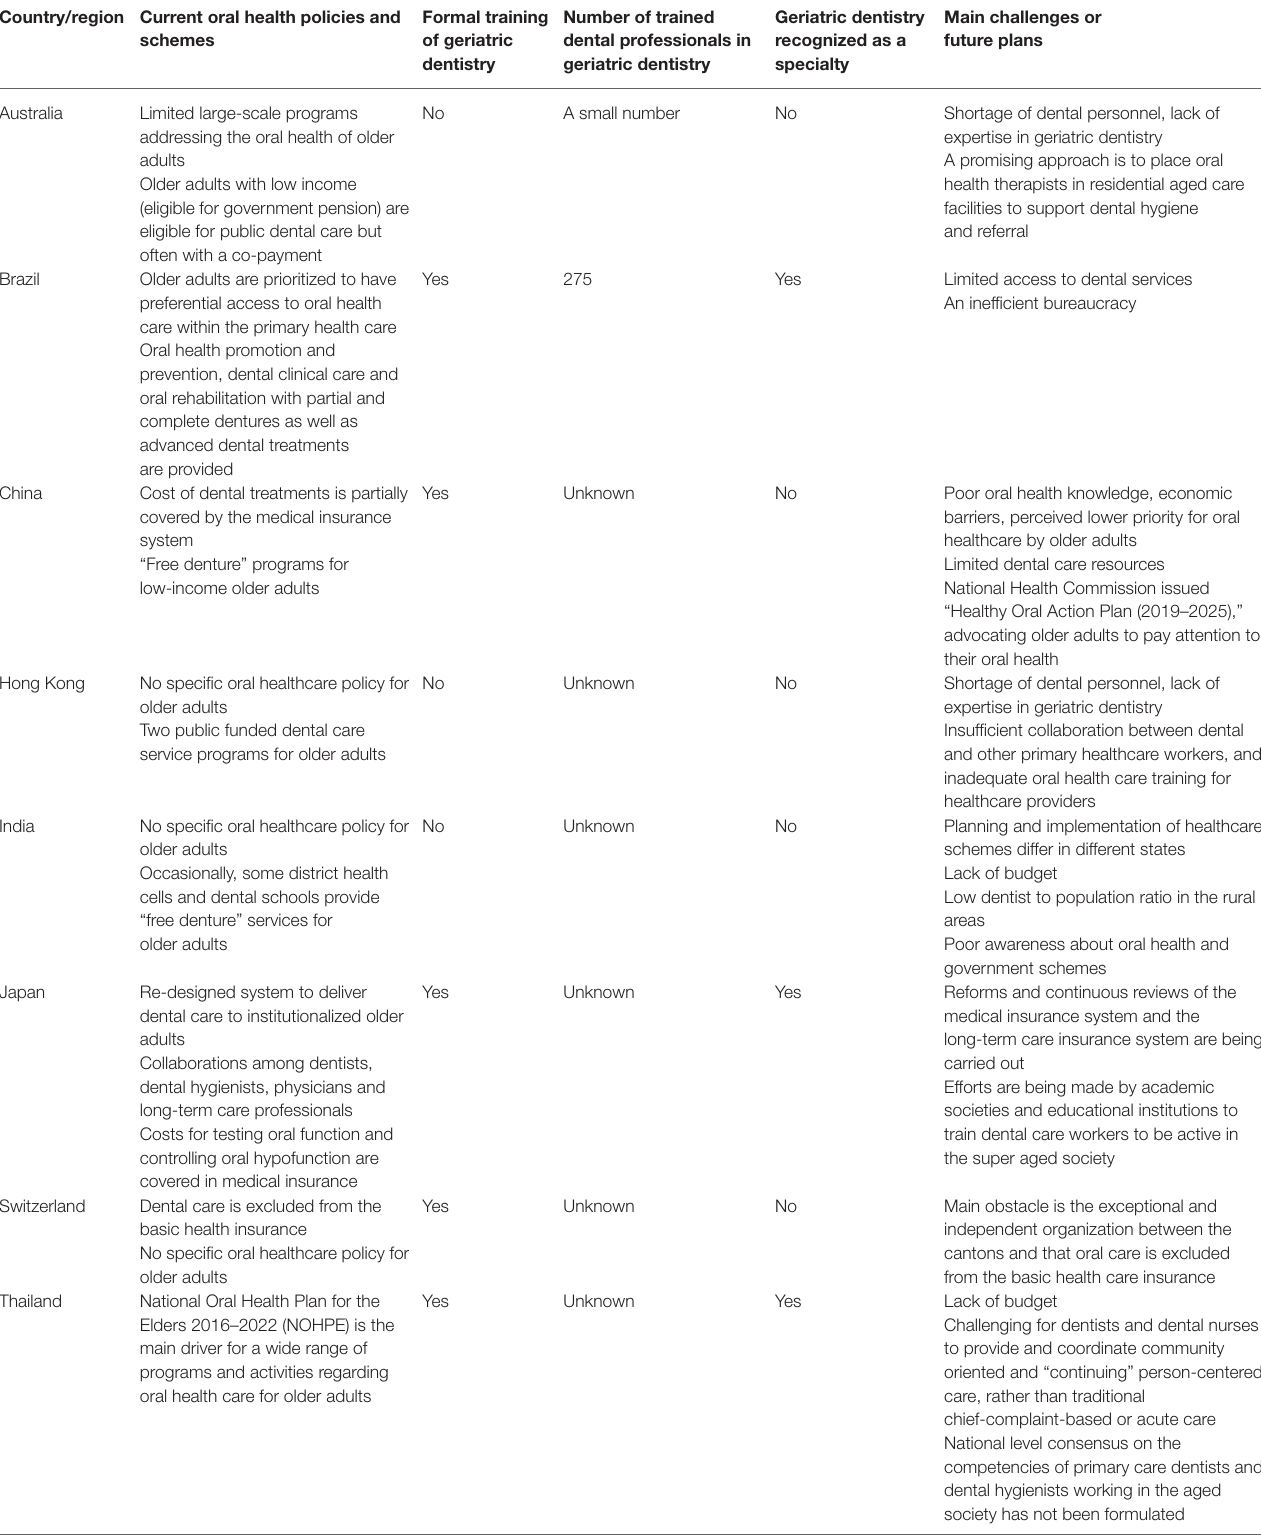
TABLE 2 | Summary of current oral health policies for older adult populations in the selected countries/regions. Country/region Current oral health policies and